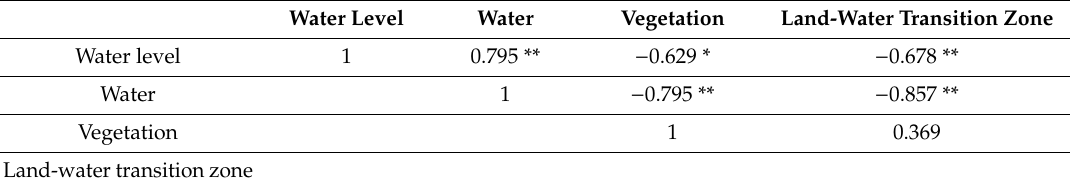
Table 4. Correlation between water level and areas of the wetland